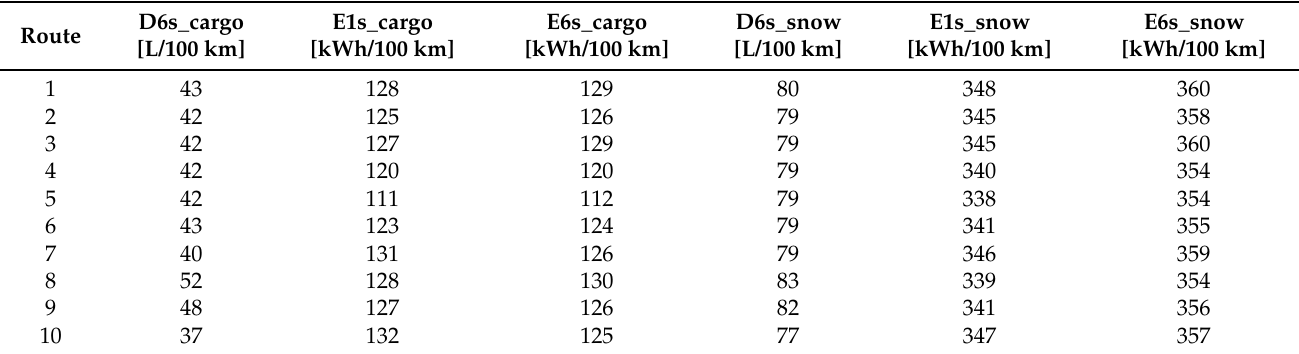
Table 7. Simulated average consumption values per 100 km, where the first three columns are from the cargo load cases and the last three columns from the snow load cases. The diesel consumption is represented in litres and the energy consumption in kWhs.